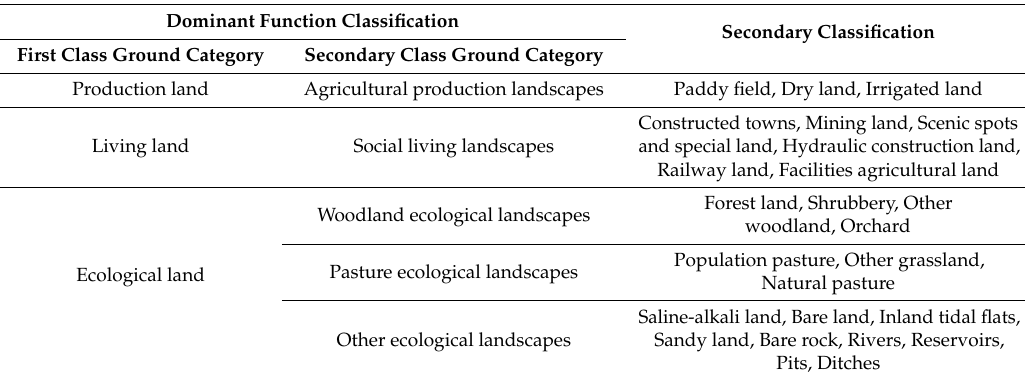
Table 1. Land-use function classification.